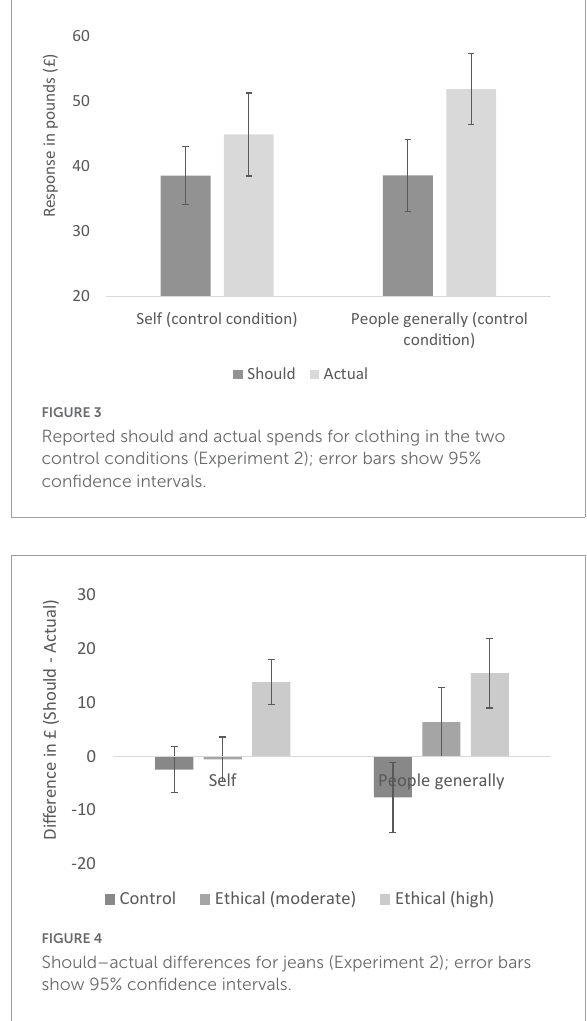
FIGURE4 Should–actual differences for jeans (Experiment 2); error bars show 95% confidence